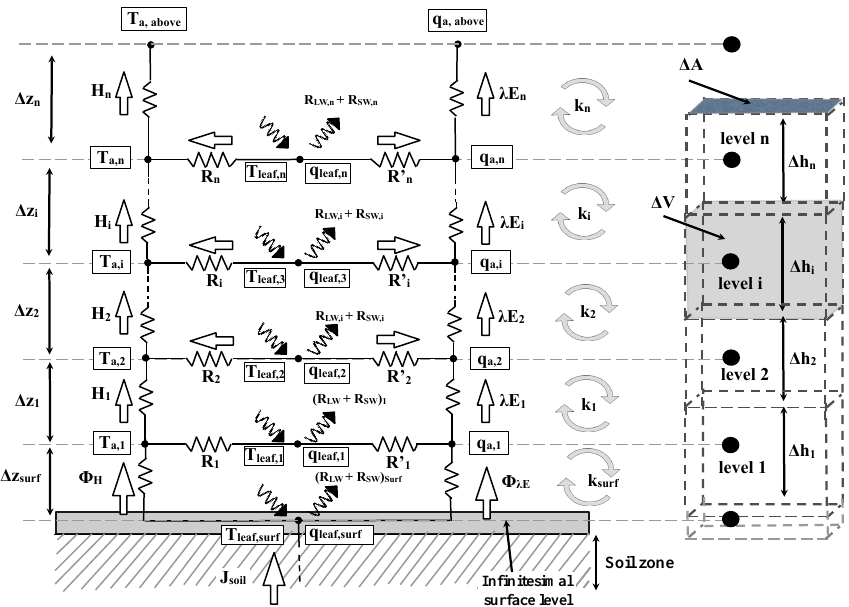
Figure 1. Resistance analogue for a multi-layer canopy approximation of n levels, to which the energy balance applies at each level. Refer to Table 1 for interpretation of the